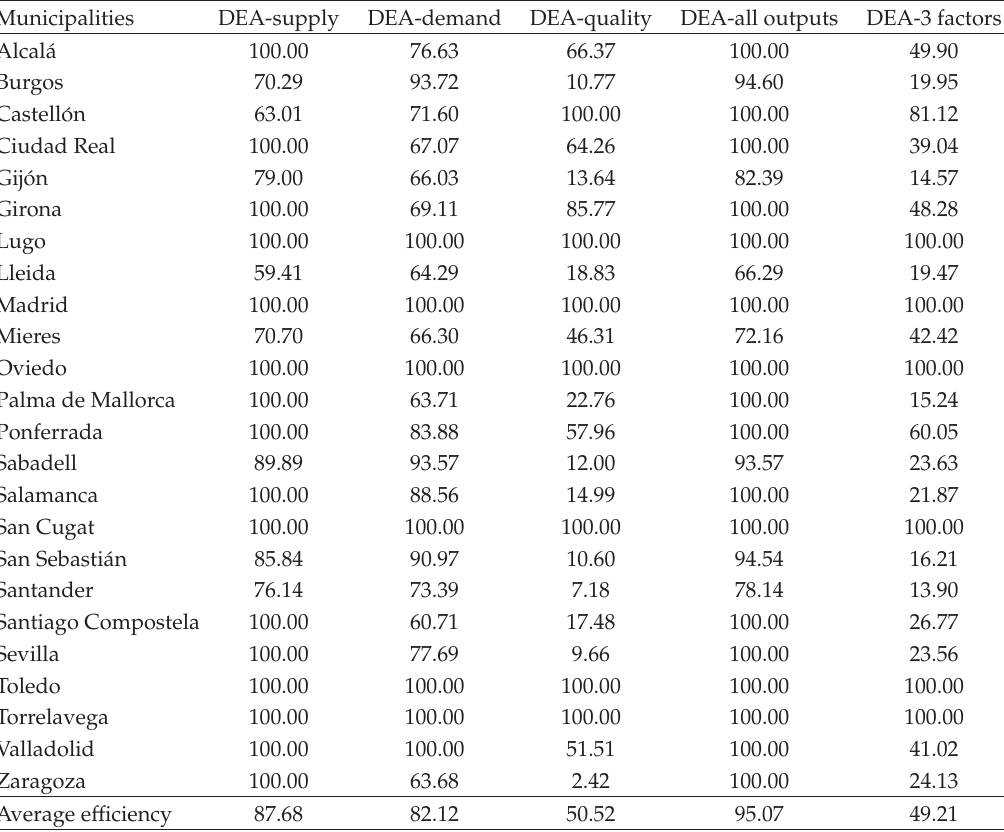
Table 4: CCR-e ffi ciency index and DEA-varying outputs.